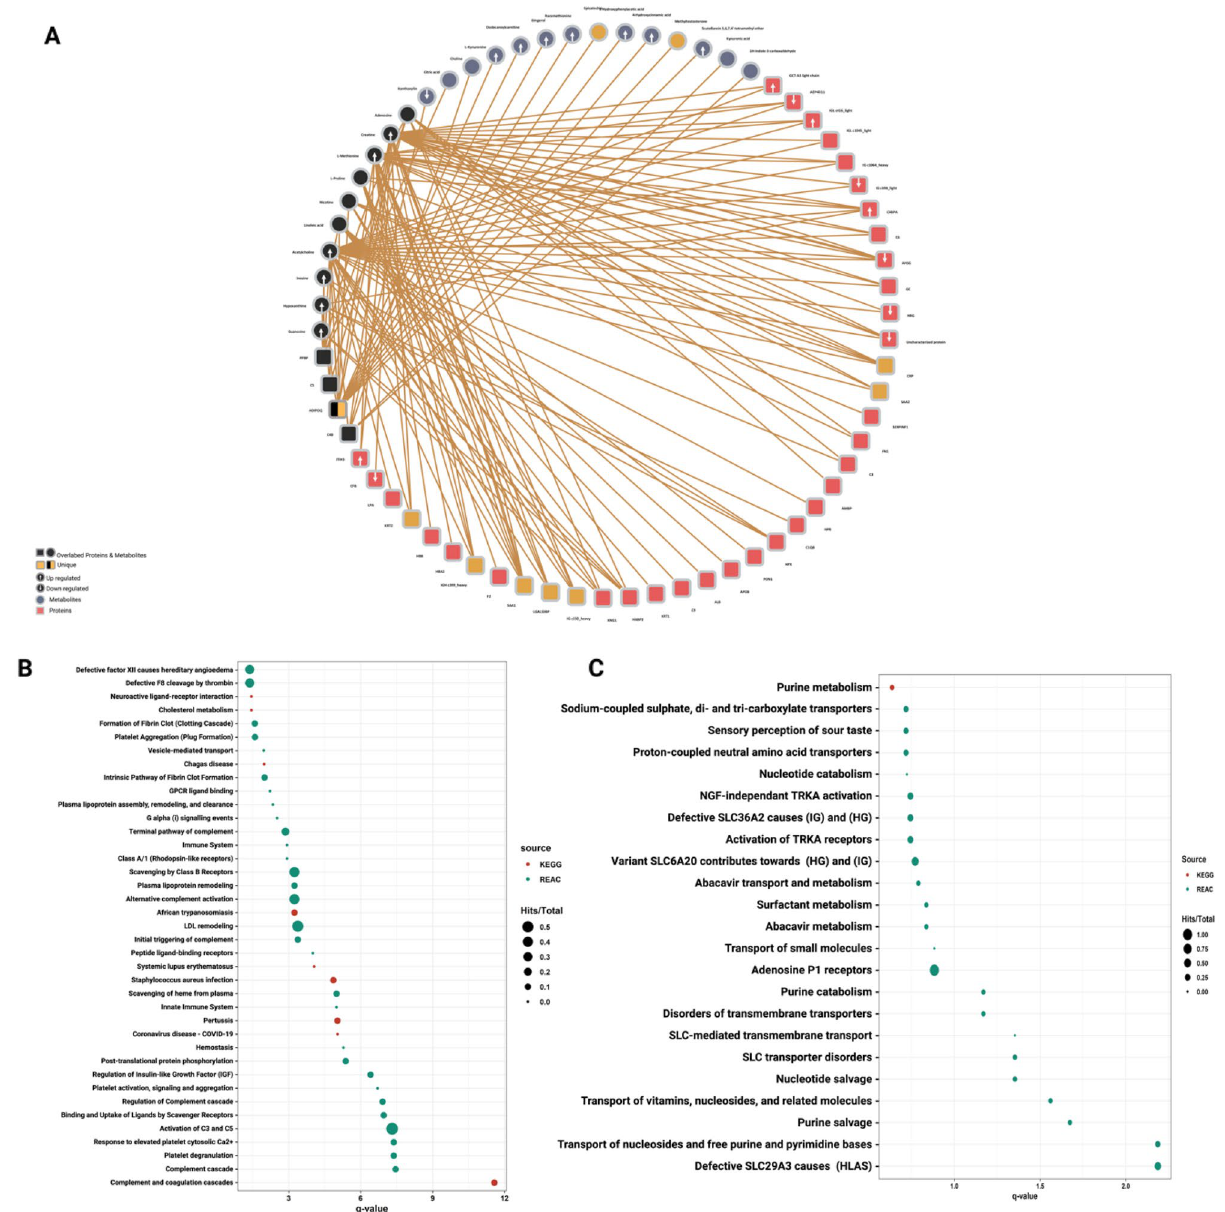
Figure 4. Integrated Knowledge-statistical-omics based network. ( A ) Integrated knowledge-statistical based network. The black colored nodes represent 14 overlapped features between the knowledge-based and the statistical-based networks interacting with 14 metabolites highlighted in blue and 39 proteins highlighted in red. Unique features highlighted in orange and each up or down regulated feature is marked with an up or down arrow as illustrated in the figure legend. ( B , C ) Pathway enrichment analyses applied on the knowledge- statistical based network and rerieved from KEGG (red) and Reactome (green) databases. The circle size reflects the number of identified hits in the pathway divided by the total entities within the same pathway. The x-axis represents the –log10 of the